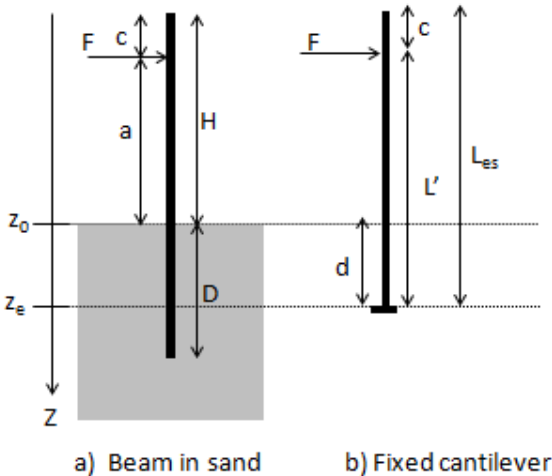
Figure 4. Definition sketch of the static equivalent length. The subfigure ( a ) shows the physical problem, whose static behavior is equivalent to the one of the cantilevered beam of the subfigure ( b ). L is the length of the beam, with D the embedded length and H the exposed length. a is the excentricity of the load to the soil level. z 0 is the soil level, and z e the level of the fixed of the cantilevered, equivalent